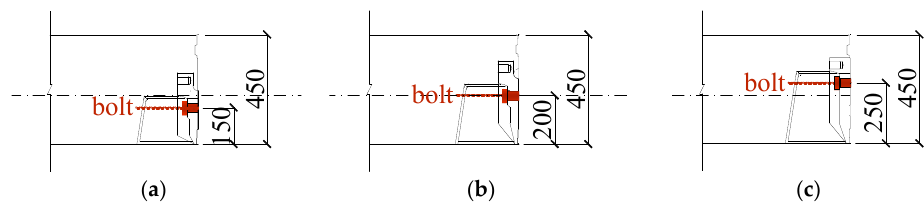
( c ) Figure 6. Cross-sectional view of the DIJPs (unit: mm): ( a ) Type-BPos; ( b ) Type-A; ( c ) Type-BNeg. 2.2. Testing Procedure Positive bending moments were respectively exerted on Type-A and Type-BPos specimens, as shown in Figure 7a. The bending moment 𝑀 and axial force 𝑁 at the joint